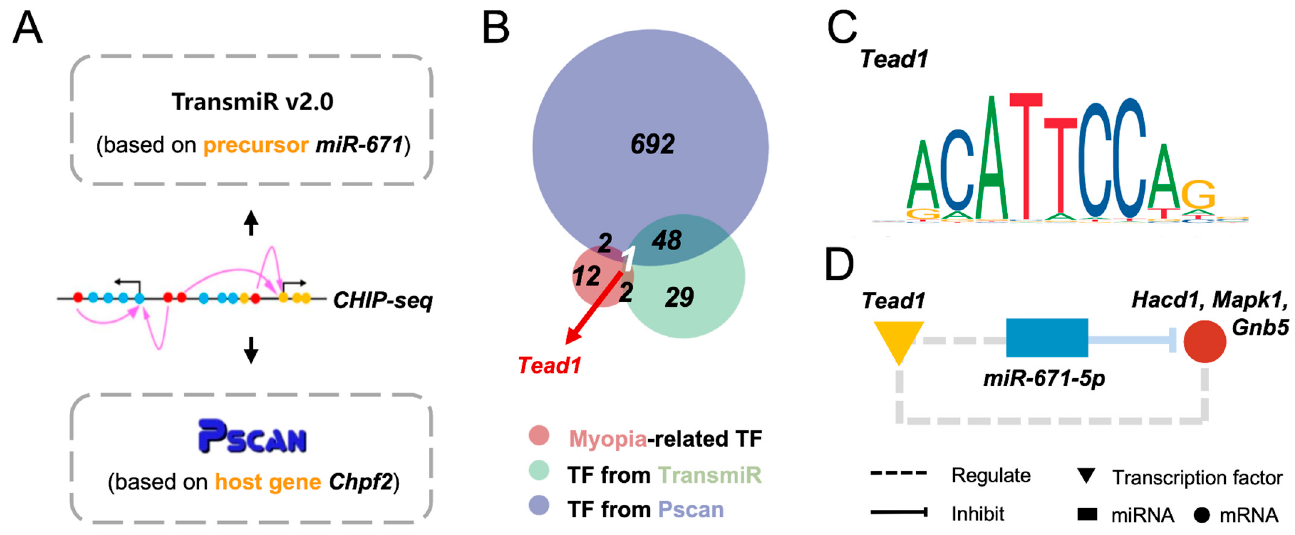
Figure 4. Prediction of the upstream regulators of miR-671-5p in myopia pathology. ( A ) Prediction of the upstream TFs of miR-671-5p based on its precursor and host gene; ( B ) Intersection of myopia-related and predicted miR-671-5p upstream TFs: Tead1 might act as the upstream regulator of miR-671-5p in myopia pathology; ( C ) The sequence of the binding site of Tead1 and miR-671-5p; ( D ) Potential regulatory patterns between Tead1, miR-671-5p and the hub target genes.